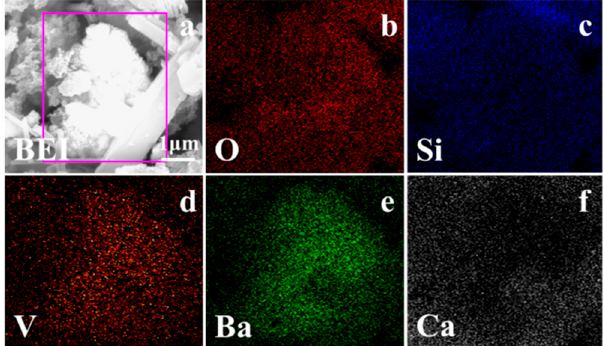
Figure 11. ( a ) BEI of leaching residual, EDS elemental distribution: ( b ) O; ( c ) Si; ( d ) V; ( e ) Ba; ( f ) Ca.